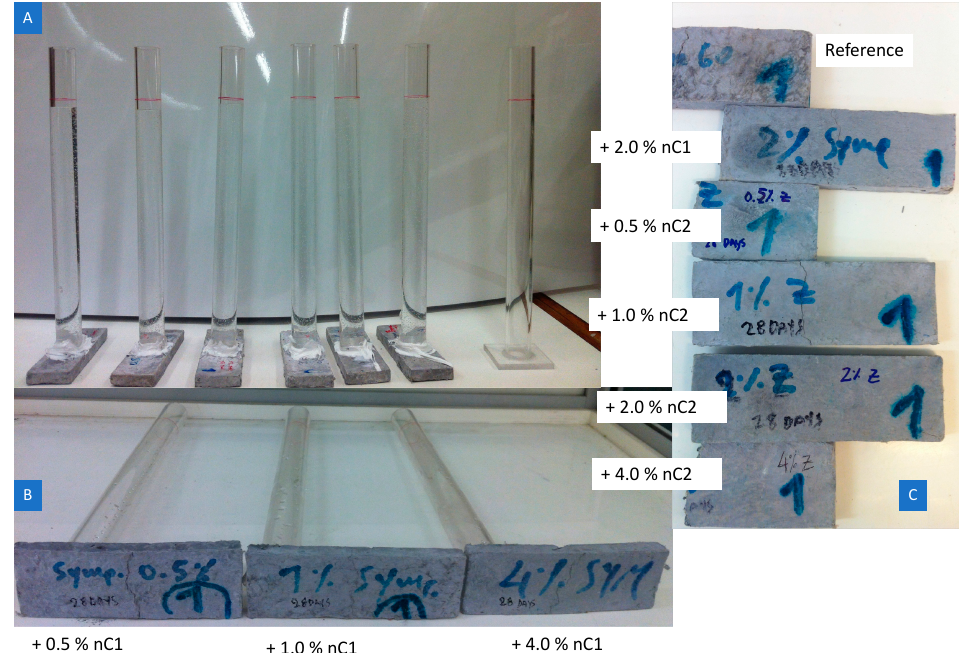
Figure 17. ( A ) Example of impermeability test, ( B ) difference in water absorption between the various concentrations of the nC1 and fibre reinforced cementitious nanocomposites and ( C ) difference in water absorption between the various concentrations of the nC2 and fibre reinforced cementitious nanocomposites based on F.PC60LS20FA20PVA3SP2.